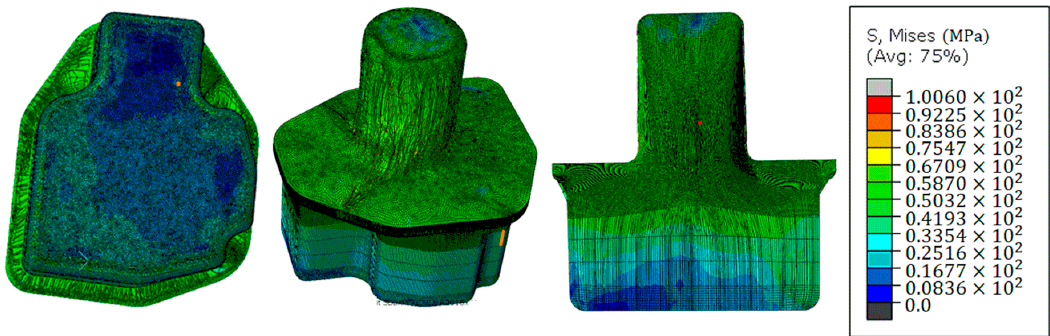
Figure10. Simulation result of hot extrusion.